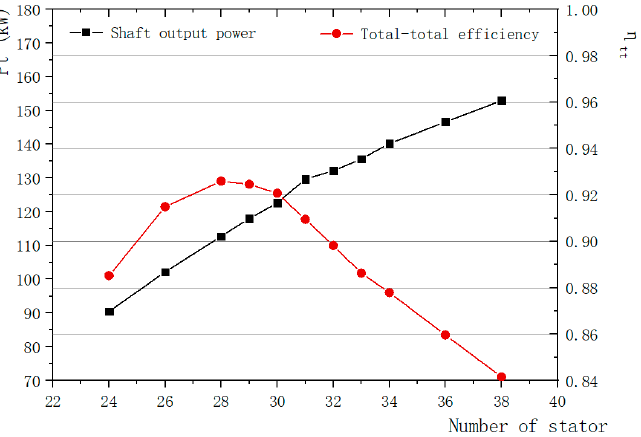
Figure 13. The influence of the number of stator blades on turbine shaft power and total-total efficiency.